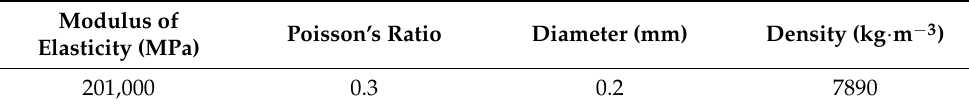
Table 2. Steel fiber material parameters [24].